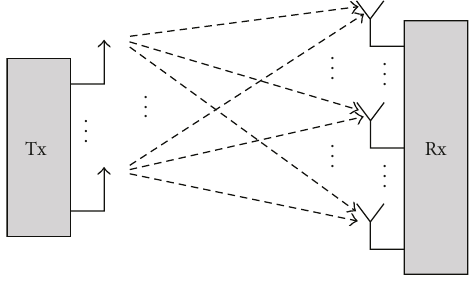
Figure 1: Schematic illustration of a MIMO system with multiple transmit and receive